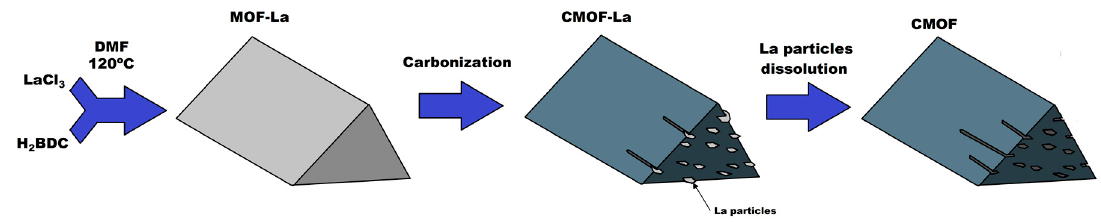
Figure Figure 1. Scheme of lanthanum-based metal–organic framework (MOF-La) and carbonized metal– organic framework before (CMOF-La) and after (CMOF) hydrochloric acid purification.